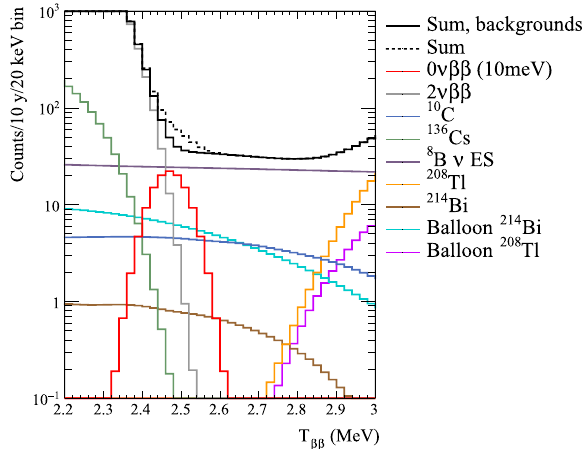
Fig. 18 Energy spectra near the NLDBD endpoint for events within the 7-m fiducial volume and for 10 years data taking. A rejection factor of 92.5% is assumed for 10 C, of 99.9% for 214 Bi, of 50% for the balloon